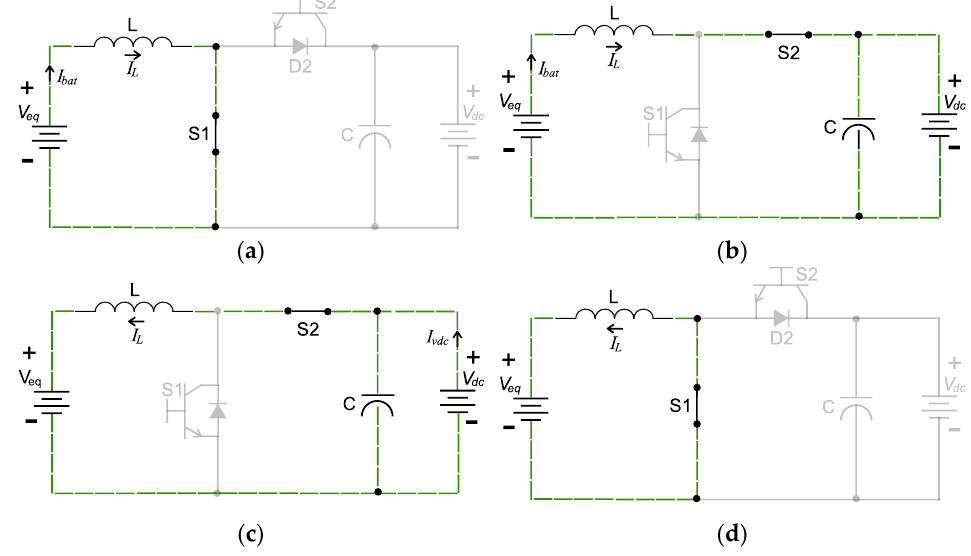
Figure 7. Bidirectional buck – boost converter operation stages: ( a ) switch S1 on, diode D2 is reverse- polarized; ( b ) switch S2 on, diode D1 is reverse-polarized; ( c ) switch S2 on, diode D1 is reverse- polarized; ( d ) switch S1 on, diode D2 is reverse-polarized.